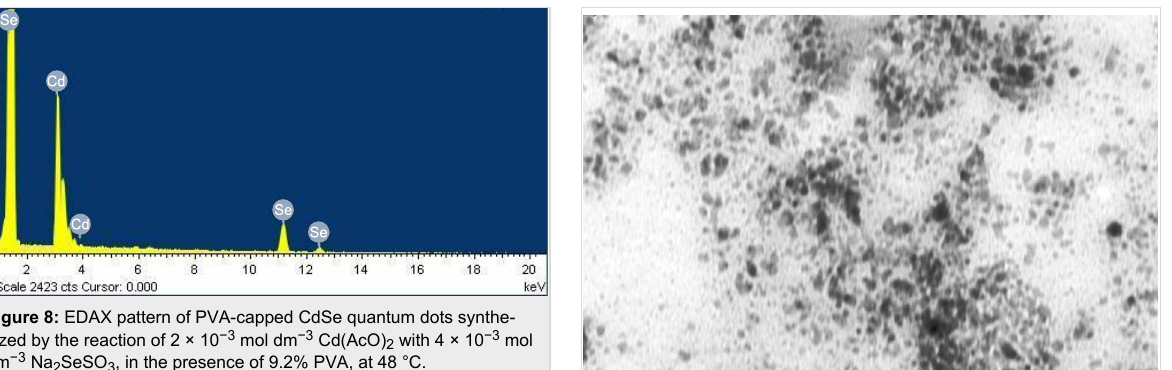
typical TEM image of CdSe quantum dots, synthesized by the reaction of 2.0 × 10 − 3 mol dm − 3 Cd(AcO) 2 with 1.0 × 10 − 3 mol dm − 3 Na 2 SeSO 3 , at 27 °C, in the presence of 9.2% PVA, is shown in Figure 9.